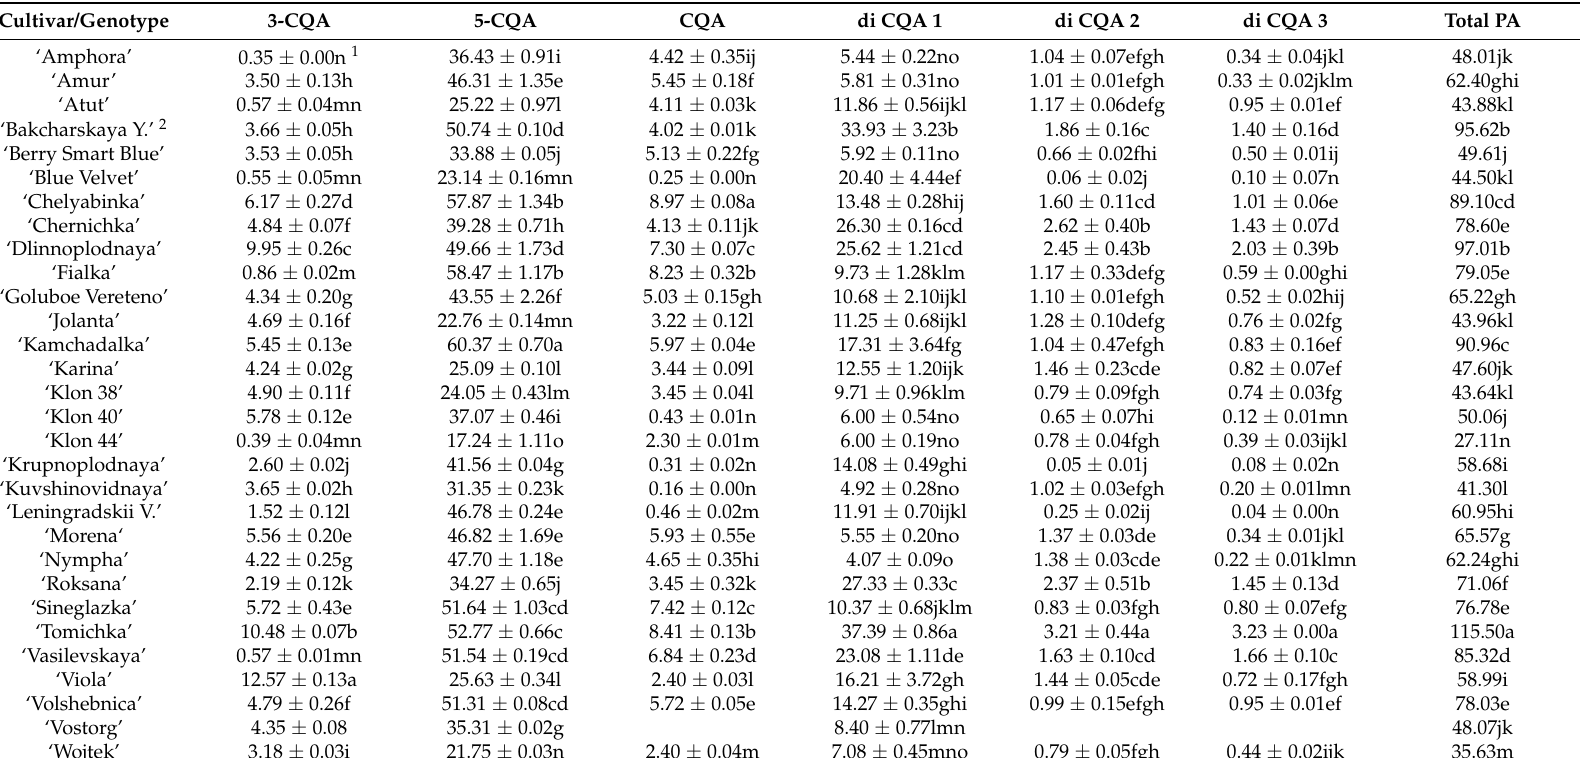
Table 6. Phenolic acid content (mg/100 g fw) of different blue honeysuckle cultivars and